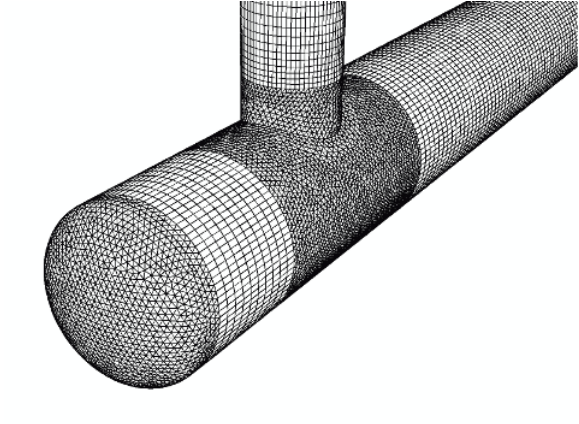
Figure 3: Surface mesh at the system inlet part